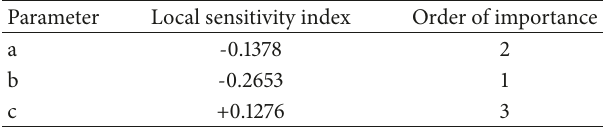
Table 1: Normalized sensitivity indexes and order of importance of 𝑥 ∗ to the three parameters evaluated at the values 𝑎 = 0.9 , 𝑏 = 0.2 , and 𝑐 = 1.2.